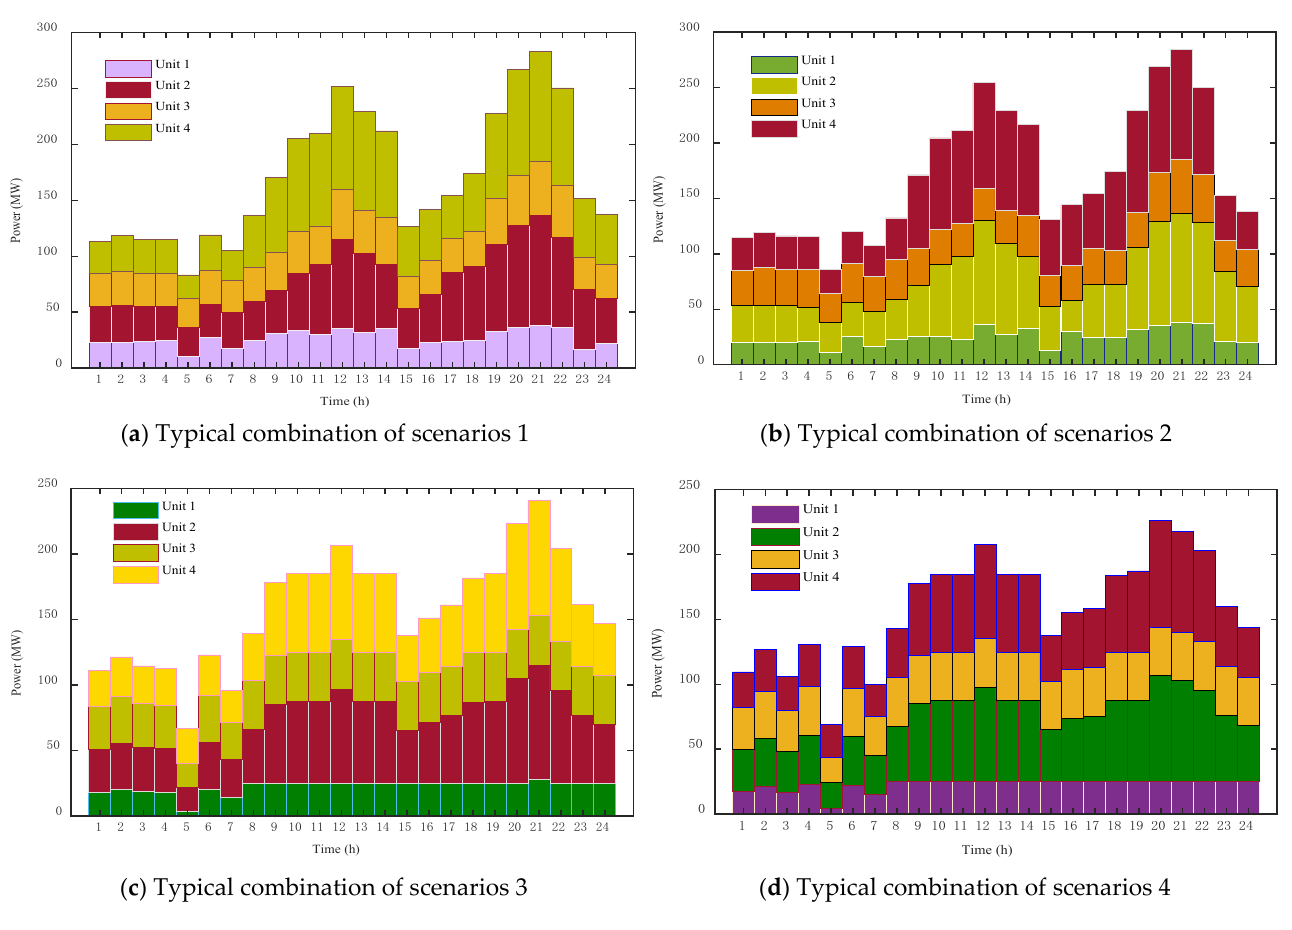
Table 4. Comparison of optimization parameters in different typical scenarios.